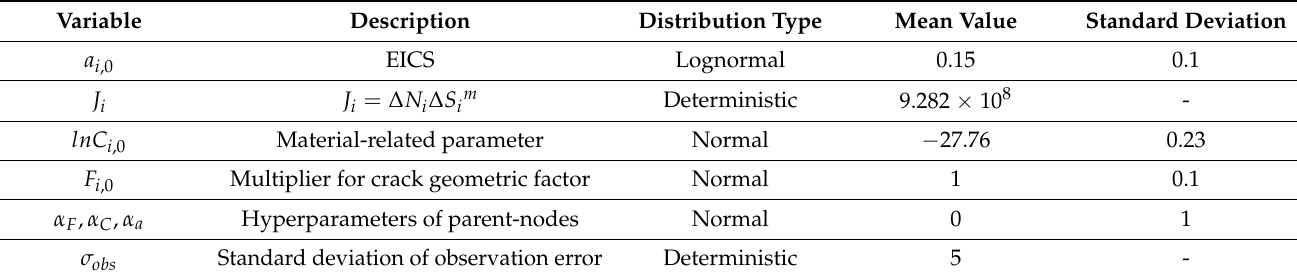
Table 4. Variable description and distribution parameters in established hierarchical DBN model.